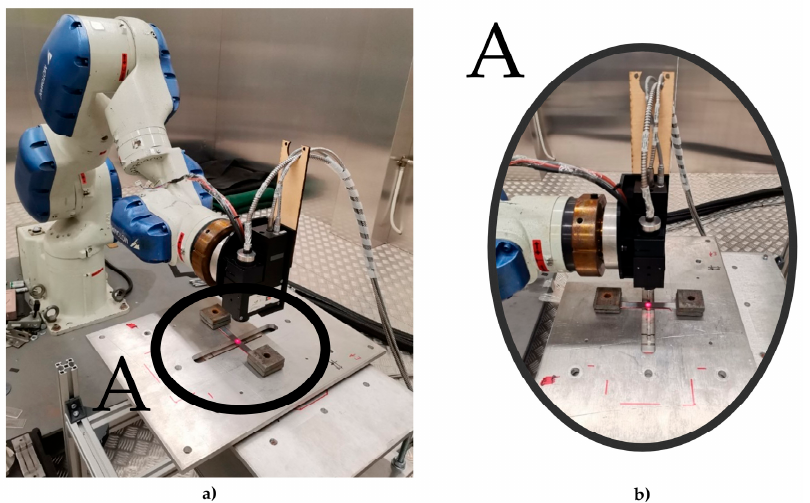
Figure 4. ( a ): ‘LM100’ diode laser head. ( b ) A detailed view of the specimen clamping